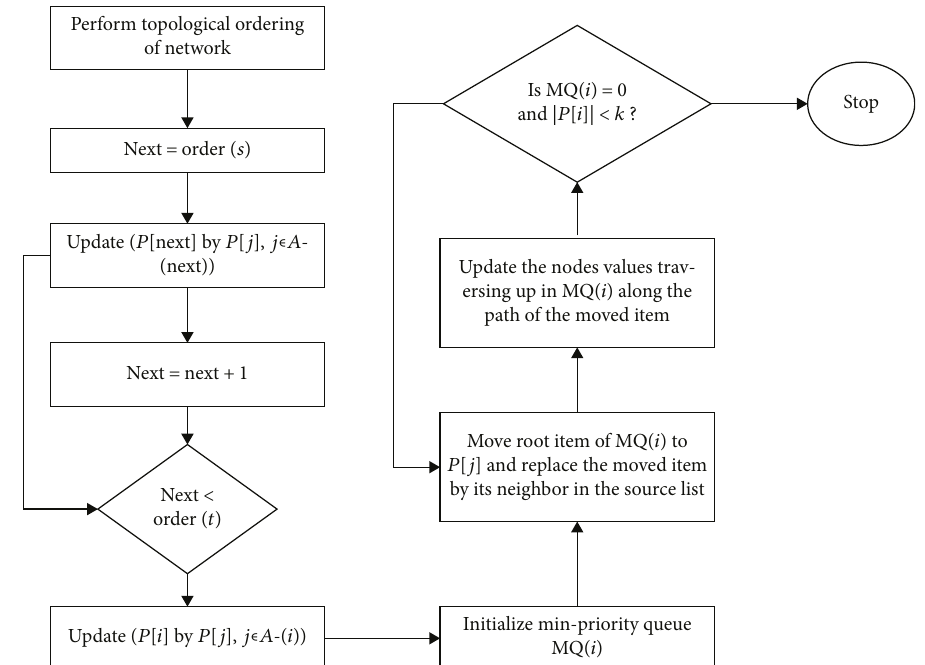
Figure 2: T ∗ algorithm fl ow chart for metabolic network